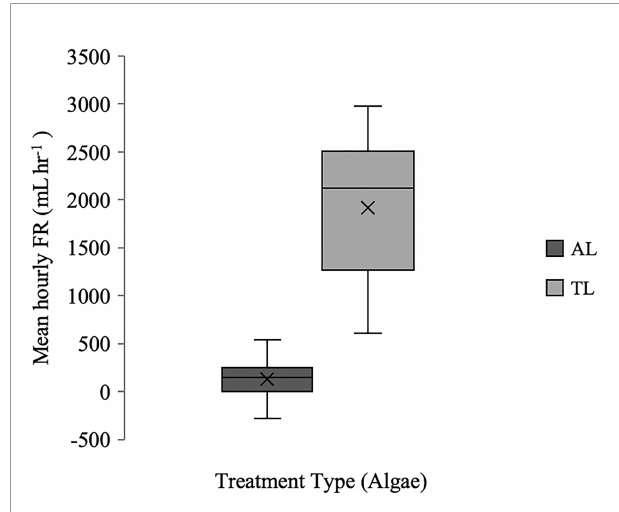
FIGURE 1 | Boxplot (x = mean, n=10) of hourly FR (mL hr -1 ) for Styela plicata exposed to Aureoumbra lagunensis (AL) or Tisochrysis lutea (TL,